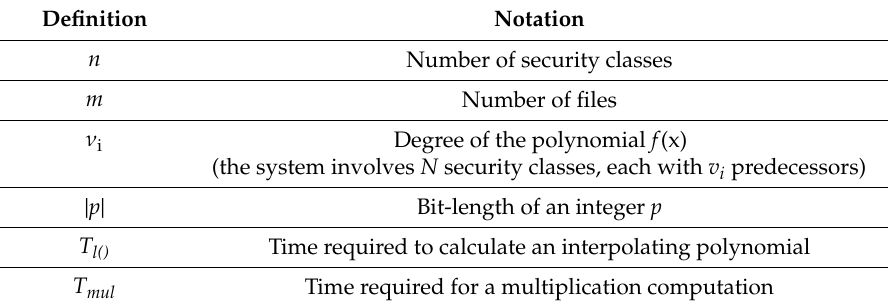
Table 7. Notation